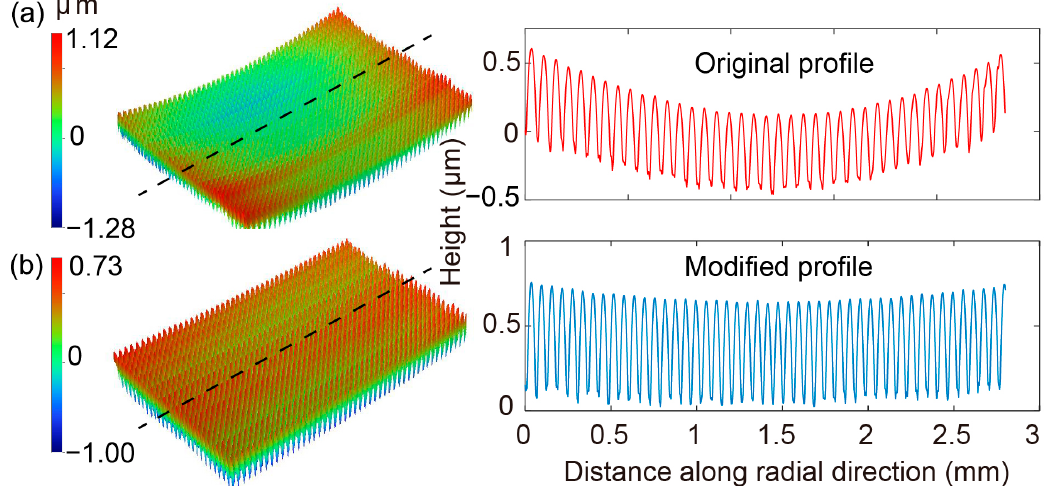
Figure 14. The warpage of the newly embossed MLA ( b ) using the modified silicon mold, with comparison to the original warpage profile ( a